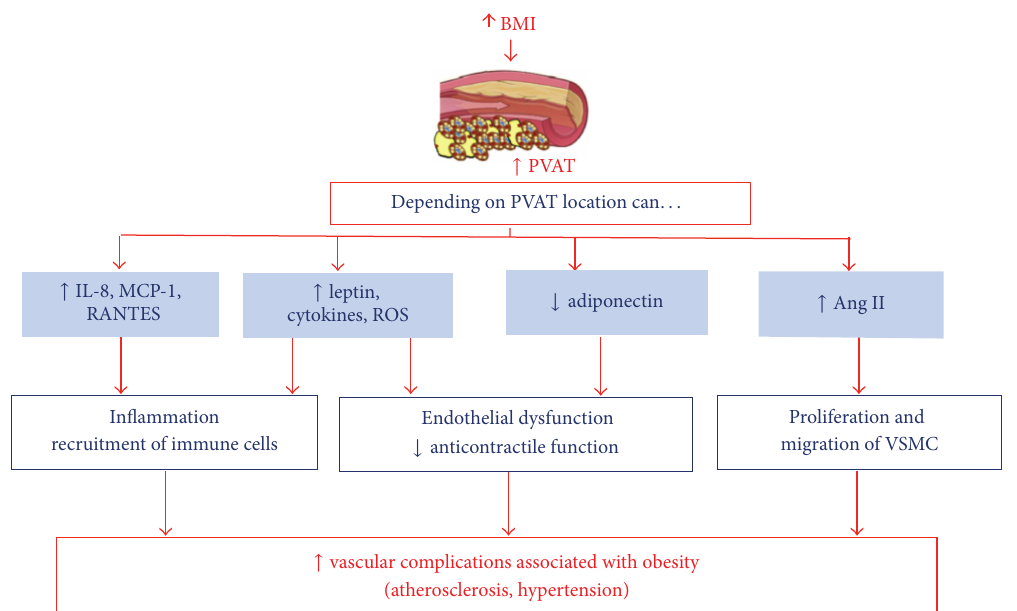
Figure 3: Contribution of perivascular adipose tissue to obesity and its associated metabolic and vascular complications. Perivascular adipose tissue depending on its location interacts with the endothelium, vascular smooth muscle cells, and immune cells. In the same way, there are certain mediators that would be involved in the vascular disorders associated with obesity, such as hypertension and